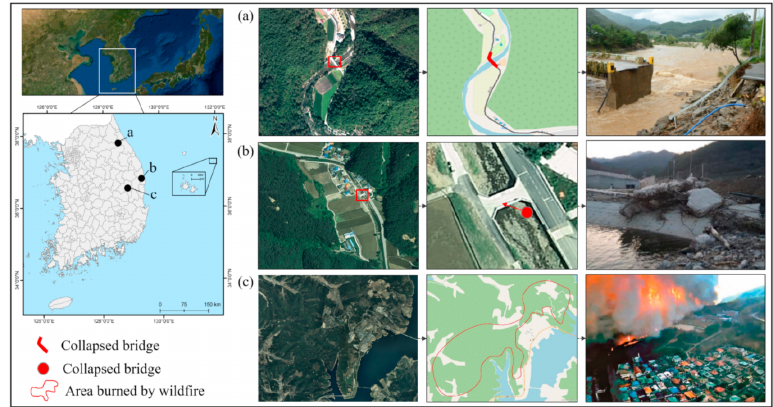
Figure 1. Study areas in South Korea: ( a ) Nae-myeon, Hongcheon-gun; ( b ) Samsan 1 ri, Uljin-gun; and ( c ) a part of Imdong-myeon, Andong City (photo courtesy of Korea Forest Service, 2021).